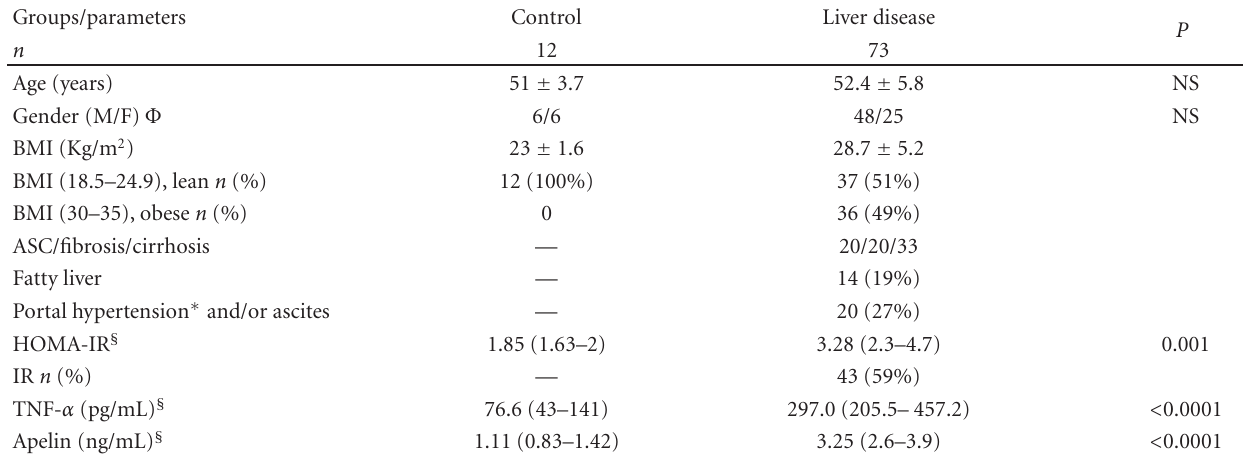
Table 1: Demographic, clinical characteristics, and studied parameters of all participants.